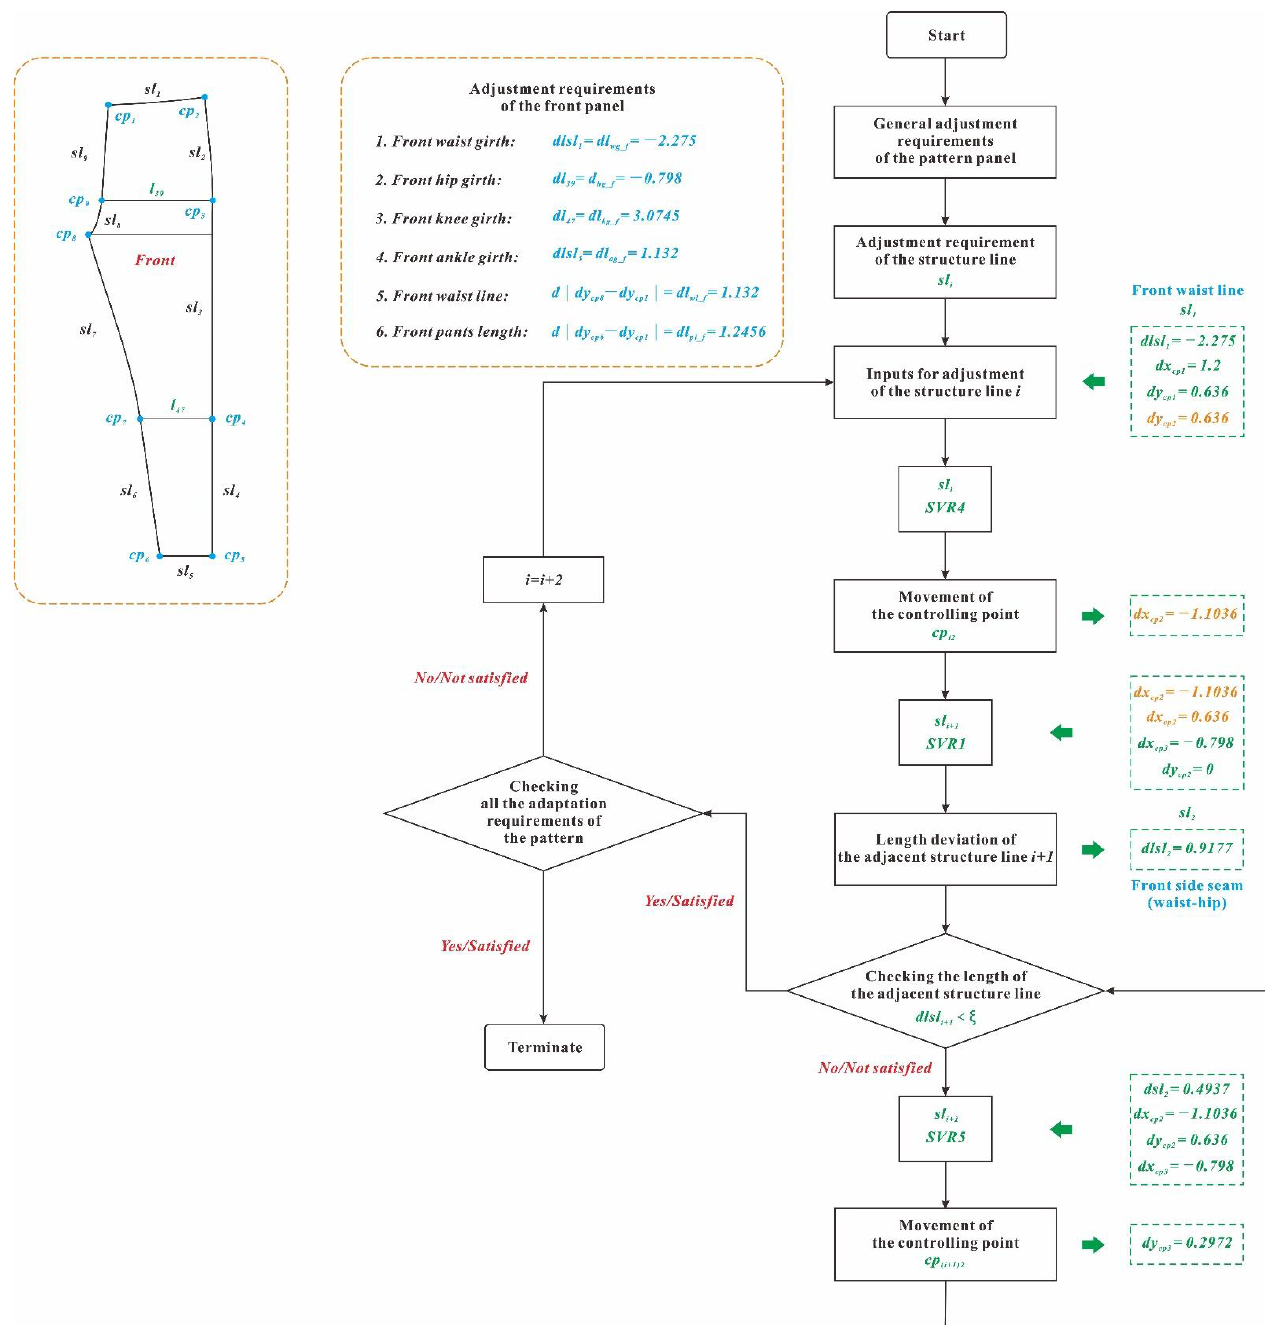
Figure 7. General adaptation flowchart of the structure lines and controlling points. Step 4: Adaptation of the back panel following the general principle described in Step 4. The final adaptation effects were illustrated in Figure 8. The hip part turned red from green for the adjusted pattern, meaning that the hip became tighter. Meanwhile, the knee part became blue, indicating that the part was looser than before.